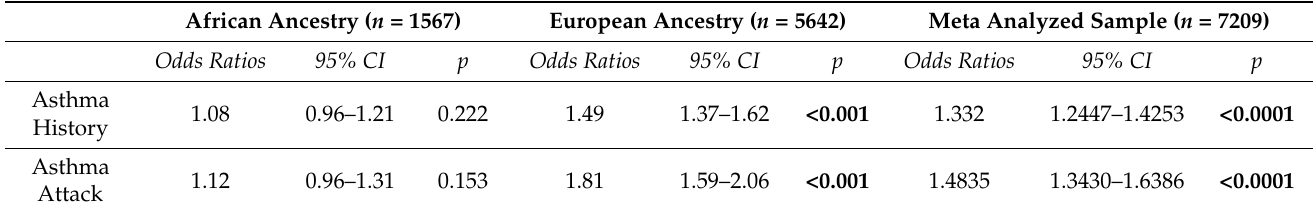
Table 2. Association of PRS-asthma a with asthma phenotypes used in this study.